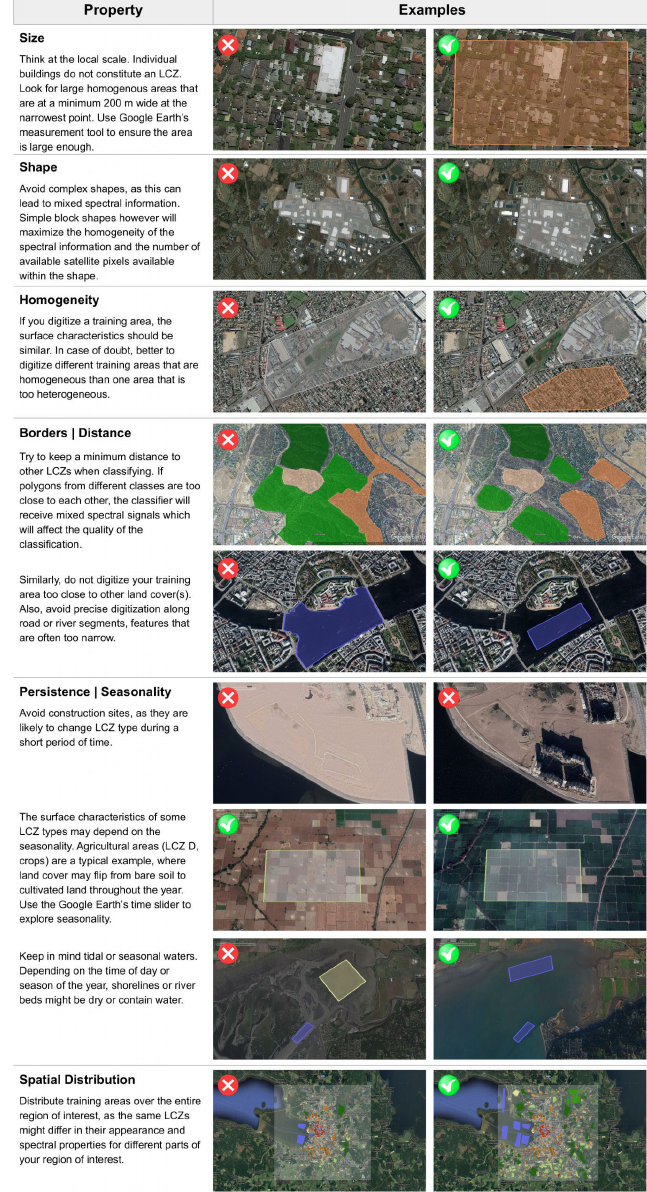
Figure A1. Good-practice guidelines for digitizing LCZ training area polygons (© Google Earth